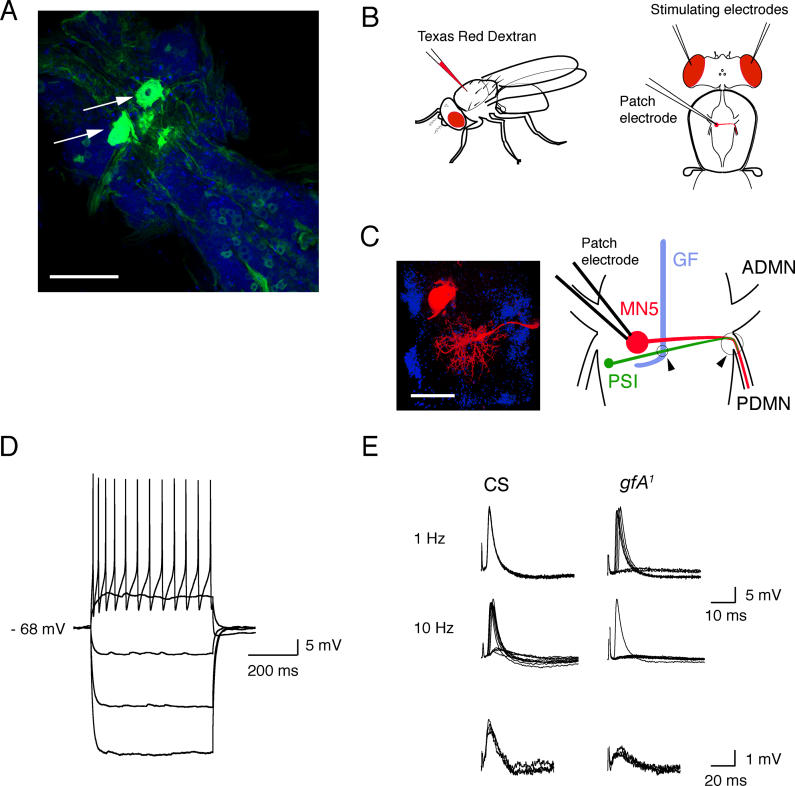
Intracellular Recordings from DLMmn(A) mCD8-GFP driven byDα7 GAL4 labels the DLMmns including the dorsal MN5 (arrows). Scale bar: 50 μm.(B) Experimental method for recording from MN5. The fly is injected in DLMs with Texas red dextran, which is then allowed to be transported back to the cell body (left). Scale bar: 50 μm. Whole cell patch clamp recordings are made from the cell body after dissection to remove the asynchronous flight muscles and the gut. The giant fiber was stimulated through insulated tungsten electrodes placed in the eyes.(C) The backfilled MN5 is shown on the left. The organization of the branch of the giant fiber circuit supplying DLMs is depicted on the right. Synapses between the giant fiber and PSI and between the PSI and DLMmn are circled and indicated with arrowheads. Abbreviations: ADMN, anterior dorsal motor nerve; GF, giant fiber; PDMN, posterior dorsal motor nerve.(D) Response of DLMmn to current injection is shown. Current pulses in steps of 200 pA were applied starting at −500 pA.(E) The top tracings show recordings from MN5 in response to 1-Hz giant fiber stimulation. The middle tracings show stimulation at 10 Hz. The bottom tracings show several overlaid EPSPs at higher magnification.